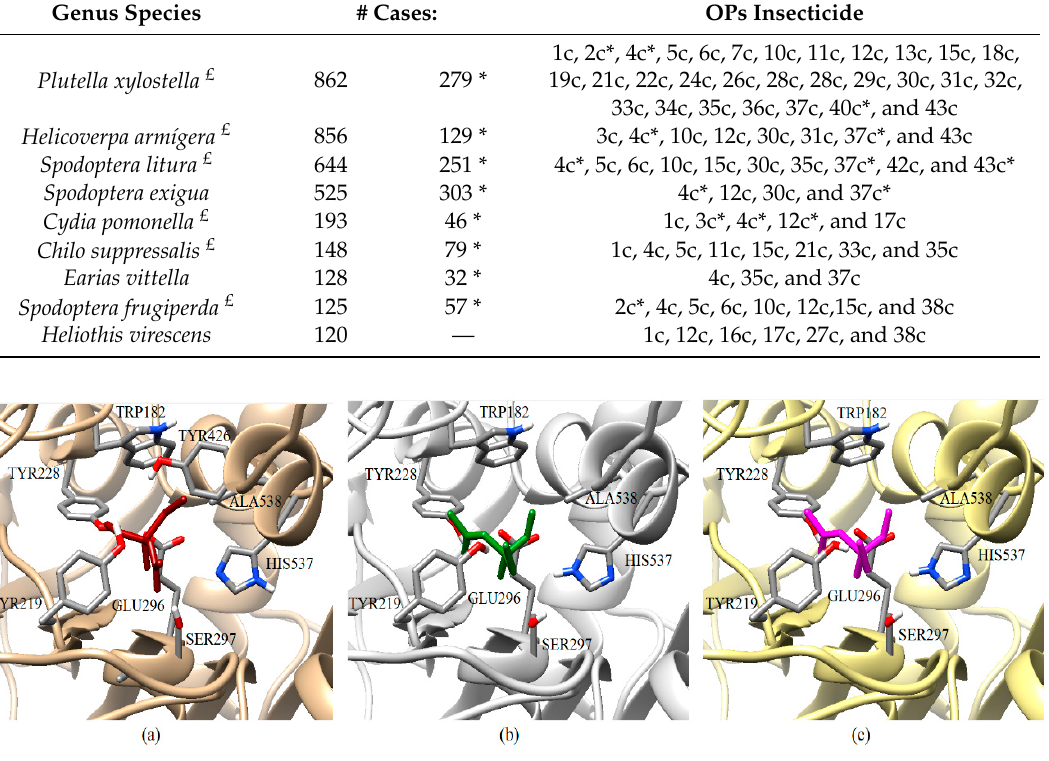
Figure 7. Graphical representation of the acephate binding on AChE-1 of P. xylostella . Spatial localization of acephate structure on the AChE-1 enzyme as a result of docking is shown in three molecular models: Conformation acquired on AChE-1 wild type, acephate is chain in red ( a ), conformation acquired on modified AChE-1 (A201S and G227A, and -A201S, G227A, and F290A, respectively), the acephate is chain in green and magenta ( b and c , respectively). The main interactions are shown in Figure 5. The location of SER297 is shown, which is an important residue for the e ff ect of enzyme phosphorylation. HIS537 in AChE-1 of P. xilostella is stabilized by GLU296 and GLU423. The p K a values of ionizable residues could be predicted with PROPKA